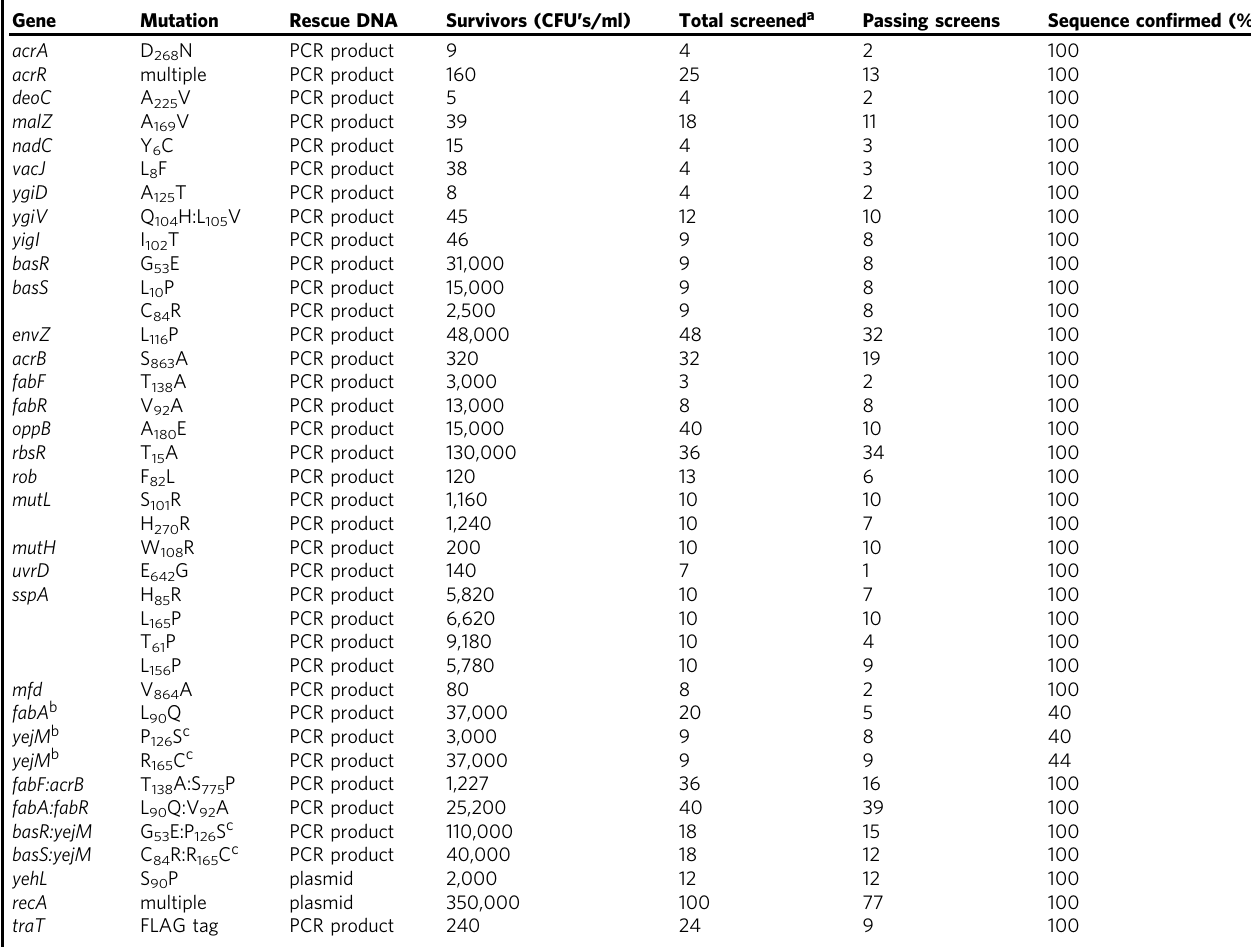
Table 1 CRISPR-FRT ef fi ciency across different genes and methods Gene Mutation Rescue